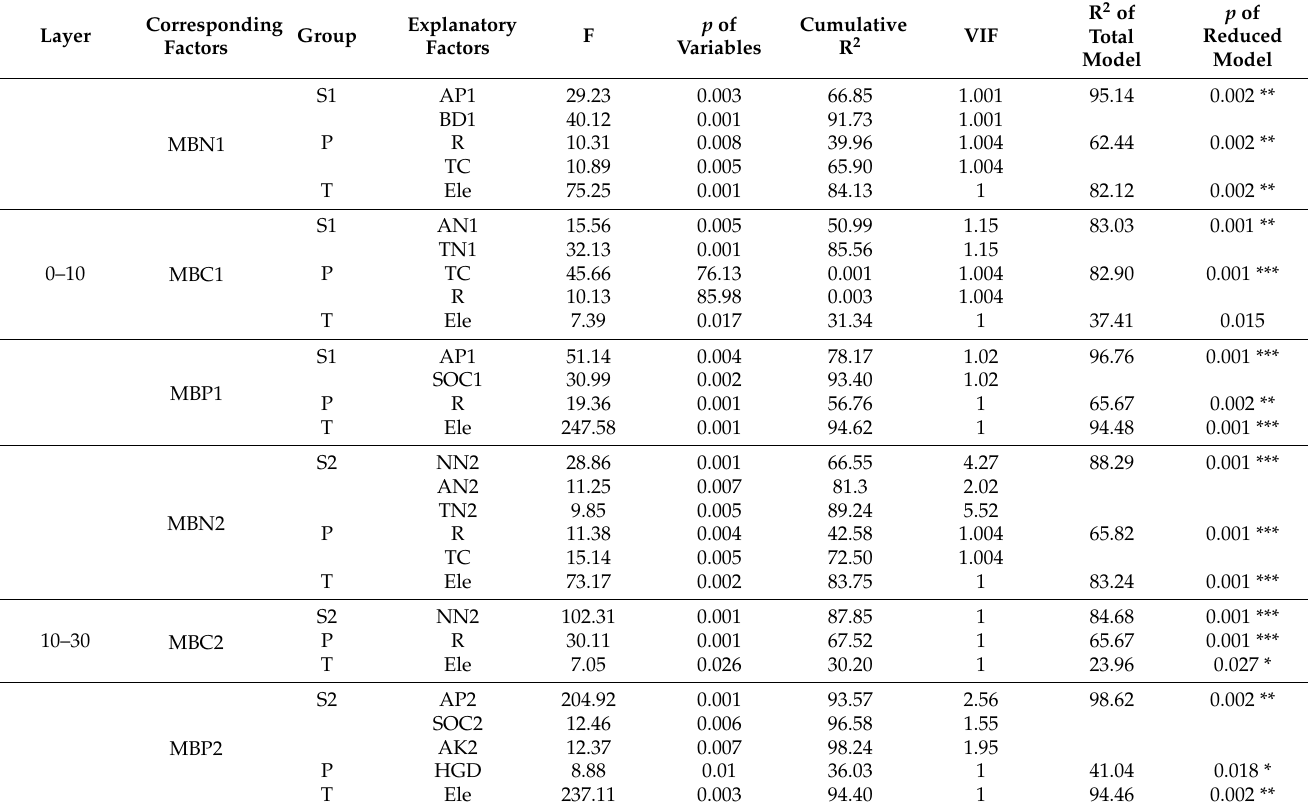
Table 3. Main drivers of soil microbial biomass (SMB) for different groups in different layers. Corresponding Explanatory Layer Group Factors